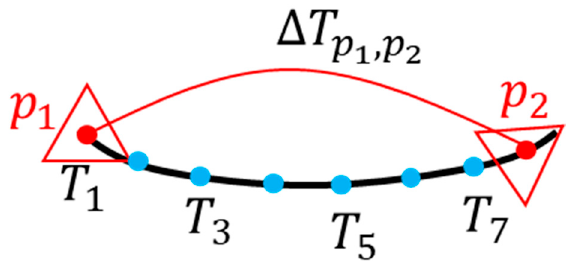
Figure 2. Schematic diagram of laser odometer between consecutive key frames.